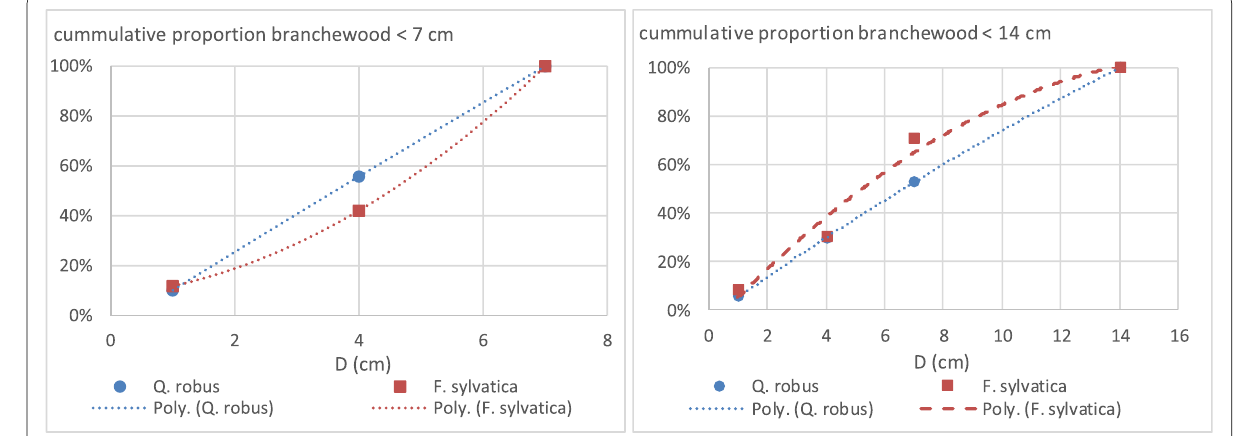
Fig. 3 Cumulativeproportion of biomass of branches at different diameter limits, based on datafrom André et al. (2010)